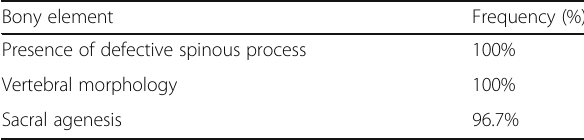
Table 6 Detailed agreement between USG and MRI